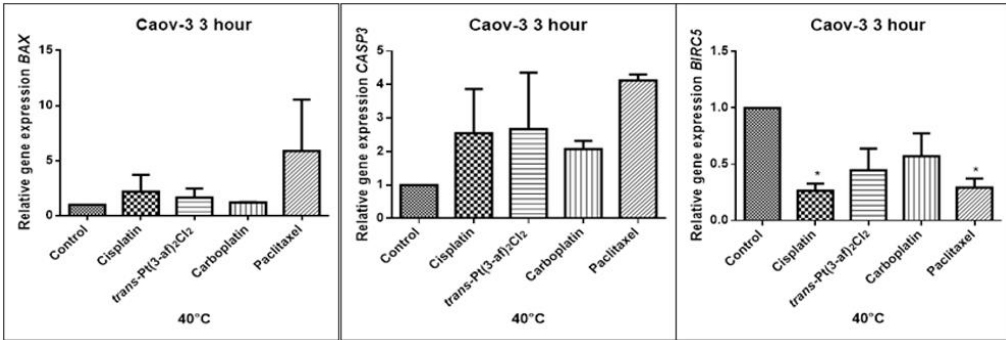
Figure 10. Level of gene expression of BAX, CASP-3, BIRC5 in ovarian cancer cells Caov-3. The gene expression level was presented as a relative value compared to a control equal to 1. The mean values marked by * ( p < 0.05) significantly differ statistically from the control.